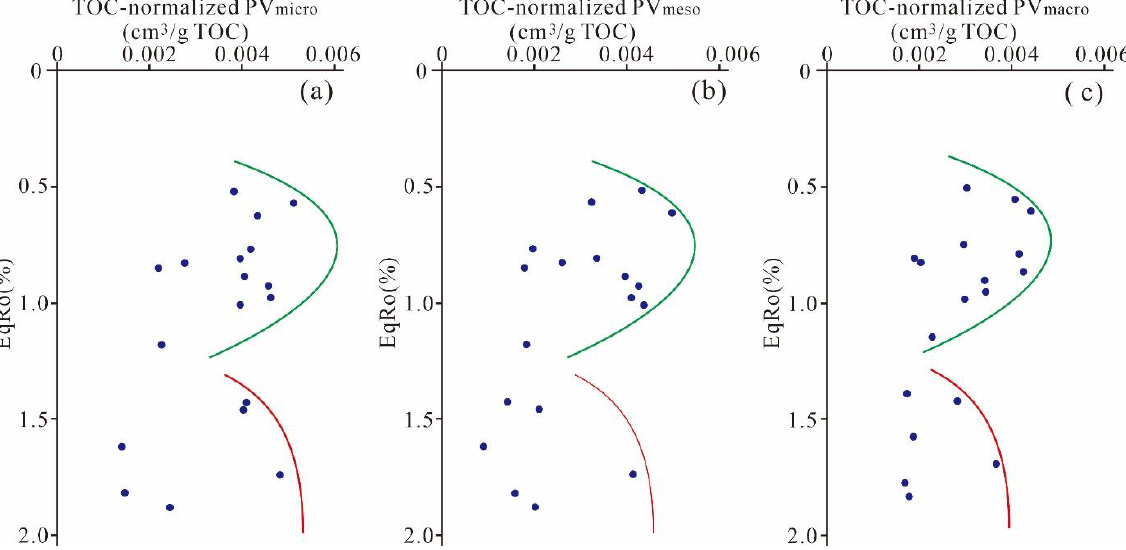
Figure 15. Evolution of TOC-normalized ( a ) micropore, ( b ) mesopore, and ( c ) macropore volume with the equivalent vitrinite reflectance.